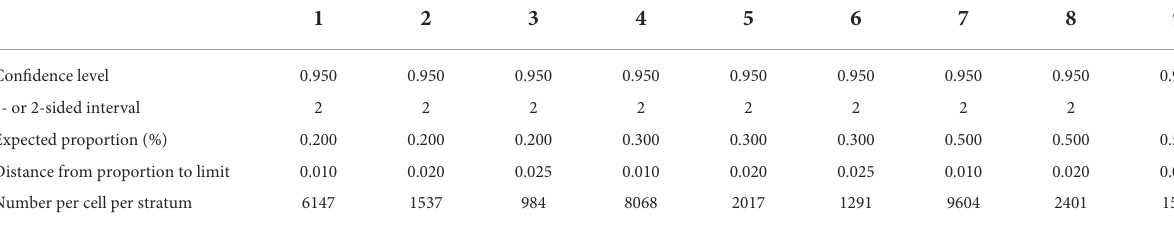
TABLE 1 Calculation of case number scenarios for study